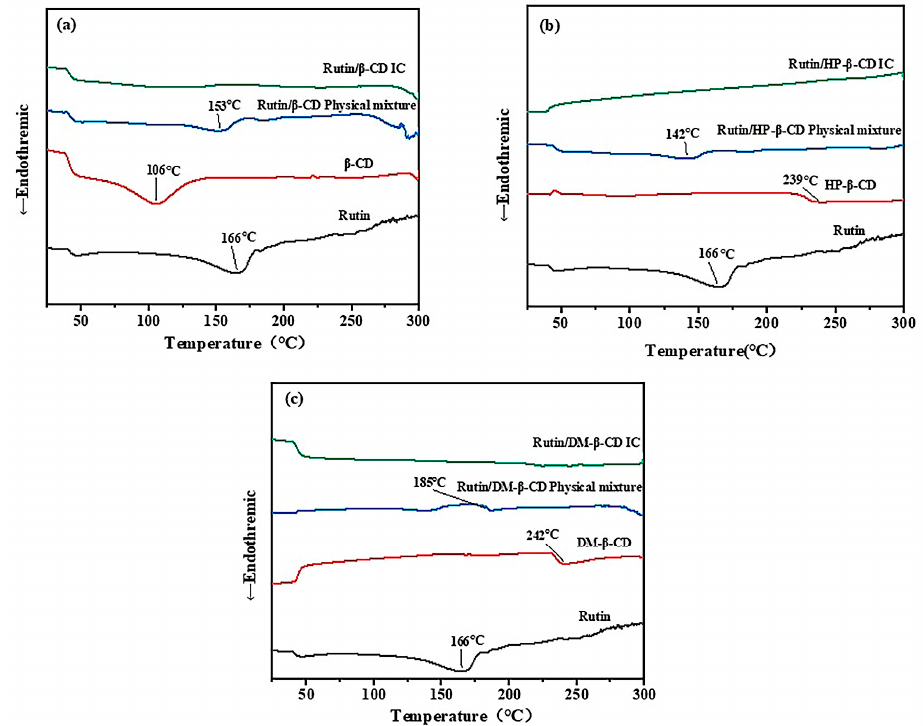
Figure 4. DSC curves of ( a ) β -CD, rutin, rutin/ β -CD physical mixture, rutin/ β -CD IC; ( b ) HP- β -CD, rutin, rutin/HP- β -CD physical mixture, rutin/HP- β -CD IC; ( c ) DM- β -CD, rutin, rutin/DM- β -CD physical mixture and rutin/DM- β -CD IC.